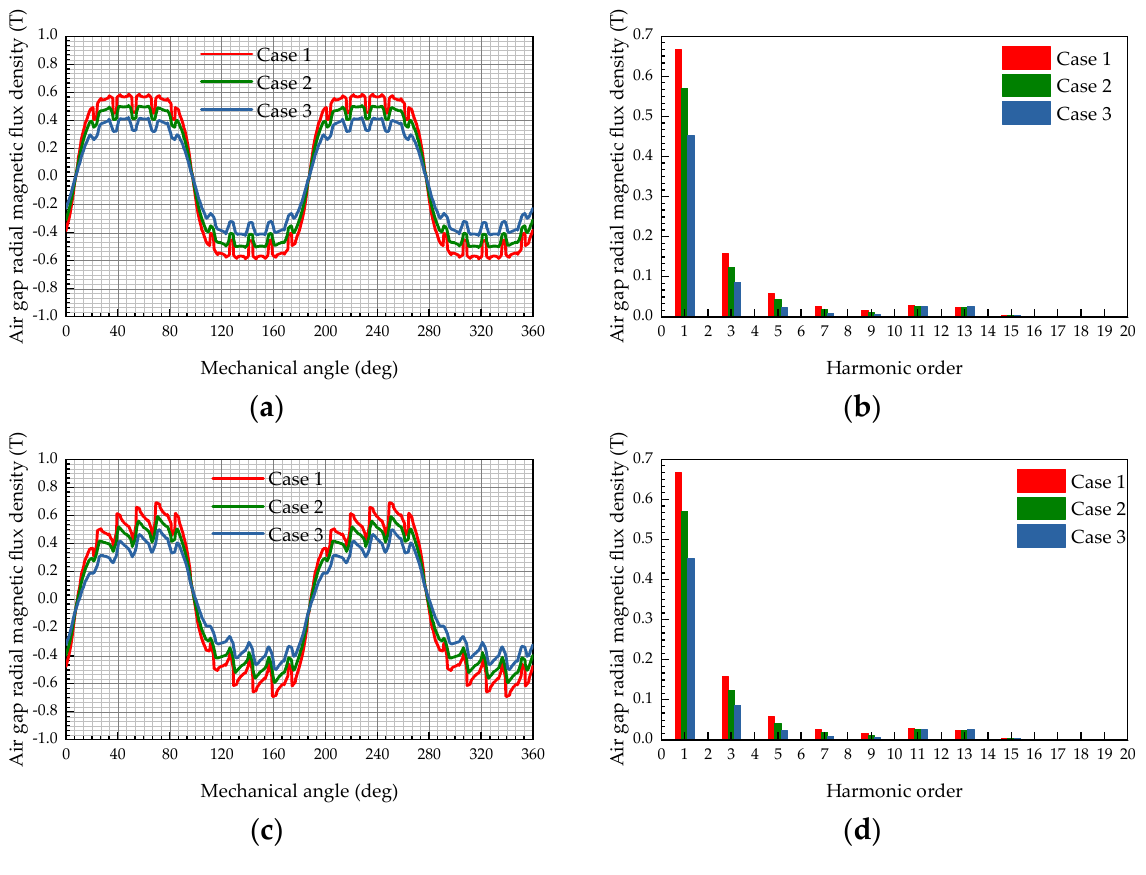
Figure 13. Radial air ‐ gap flux density and Fourier transforms under three cases at no load and rated load: ( a ) radial air ‐ gap flux density at no load; ( b ) Fourier transforms results at no load; ( c ) radial air ‐ gap flux density at rated load; ( d ) Fourier transforms results at rated load.